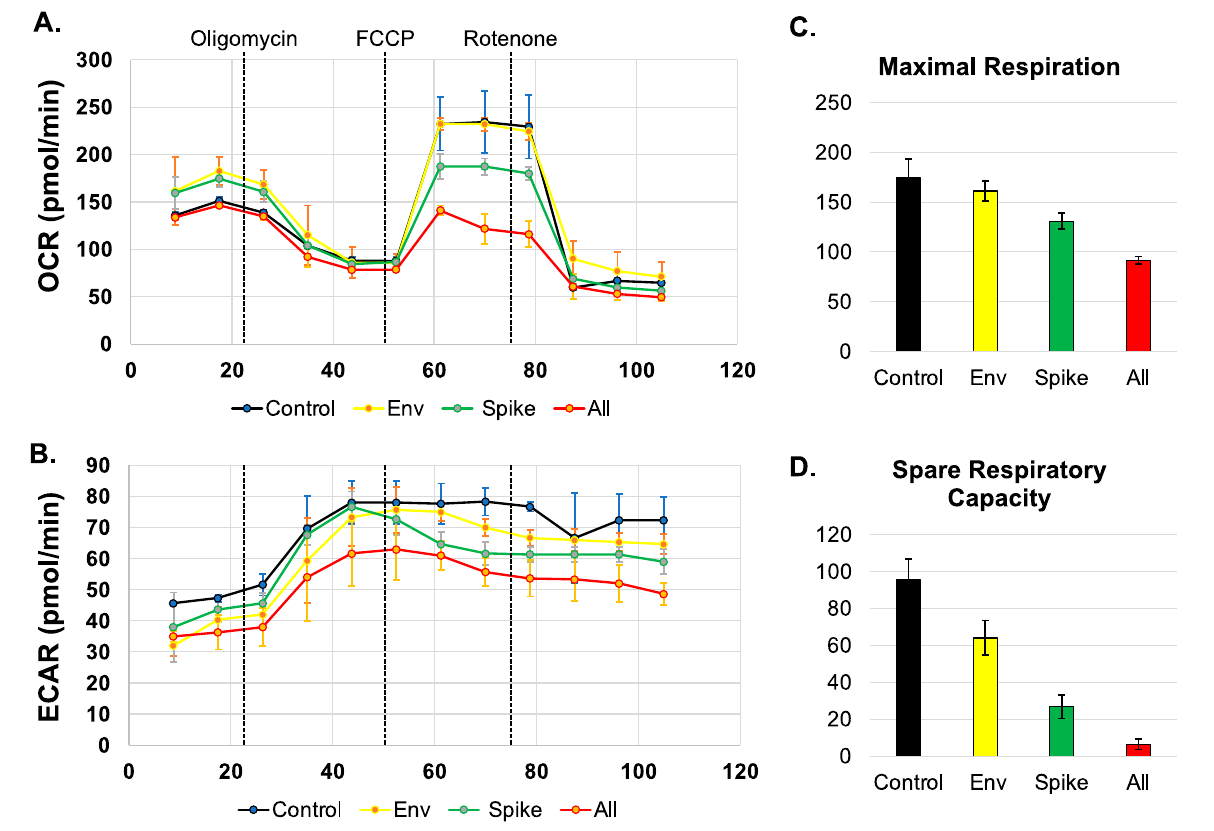
Figure 2. SARS-CoV-2 proteins alter mitochondrial maximal respiration. ( A , B ). Measurement of oxy- gen consumption rate (OCR) and extracellular acidification rate (ECAR) in BEAS-2B cells untreated or transfected with SARS-CoV-2 proteins for 48 h using a Seahorse XFe96 analyzer and a Mito stress test kit from Seahorse. Oligomycin, FCCP, and rotenone/antimycin (arrows) were added at 23, 50, and 75 min, respectively. ( C , D ). Graphs displaying the maximal respiration and spare capacity measured (pmol/min).